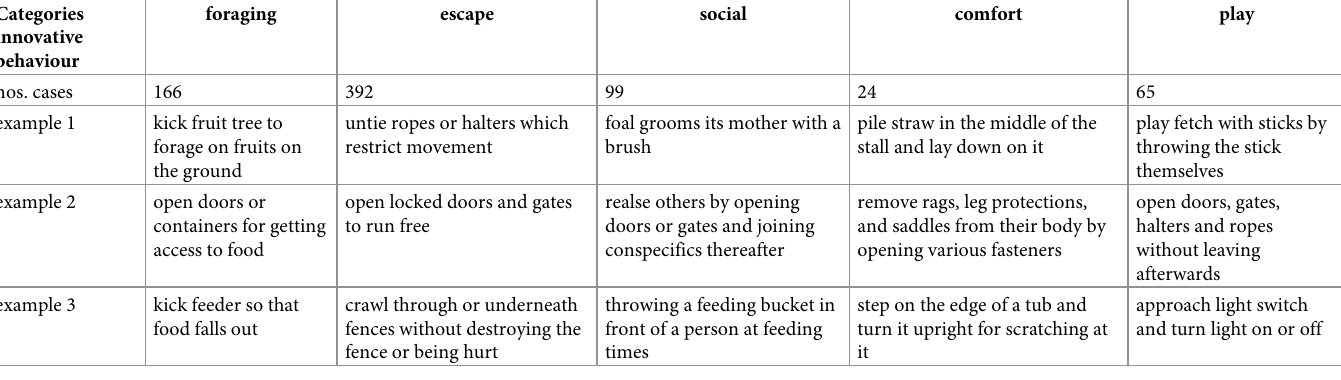
Three examples are given for each